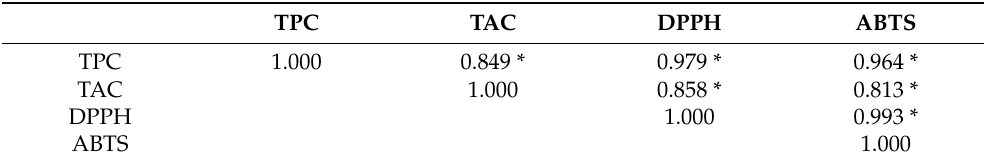
Table 5. The correlation between total phenolic content (TPC), total anthocyanin content (TAC), DPPH radical scavenging activity, and ABTS radical scavenging activity was determined using Pearson’s coe ffi cient for all samples of purple rice fl our. TPC TAC